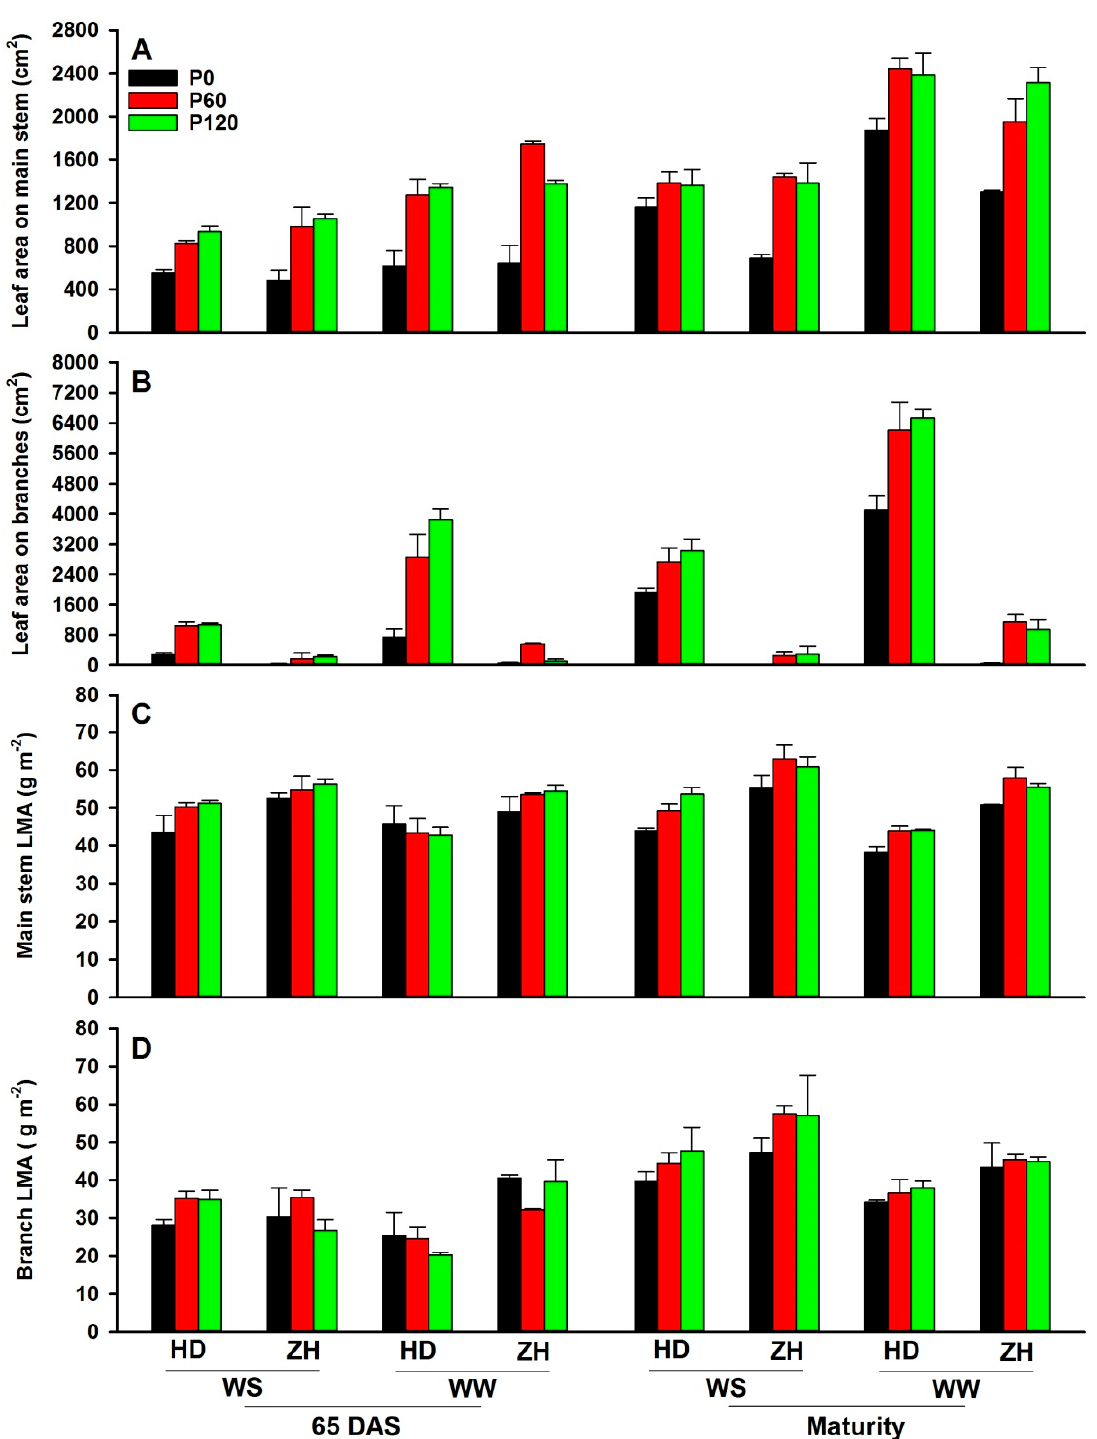
Figure 1. ( A ) Main stem and ( B ) branch leaf areas, and ( C ) main stem and ( D ) branch leaf mass areas (LMAs) at 65 days after sowing (DAS) and at maturity of soybean genotypes Huangsedadou (HD) and Zhonghuang 30 (ZH) with three applied P levels (0 (P0), 60 (P60) and 120 (P120) mg P kg –1 dry soil) and two water treatments (well-watered (WW) and cyclic water stress (WS)). Values are means + one standard error of the mean ( n = 3). Phosphorus supply increased the leaf area at all leaf positions on the main stem, except for the lowest two leaf positions at 65 DAS (Supplementary Figure S1A–D). At maturity, P deficit (P0) reduced the leaf area on the main stem from leaf positions 5–10 in HD and each leaf position in ZH (Supplementary Figure S1). The leaf area on the branches in both genotypes also decreased significantly under P deficit, as did the branch number at 65 DAS and maturity (Supplementary Figure S2).